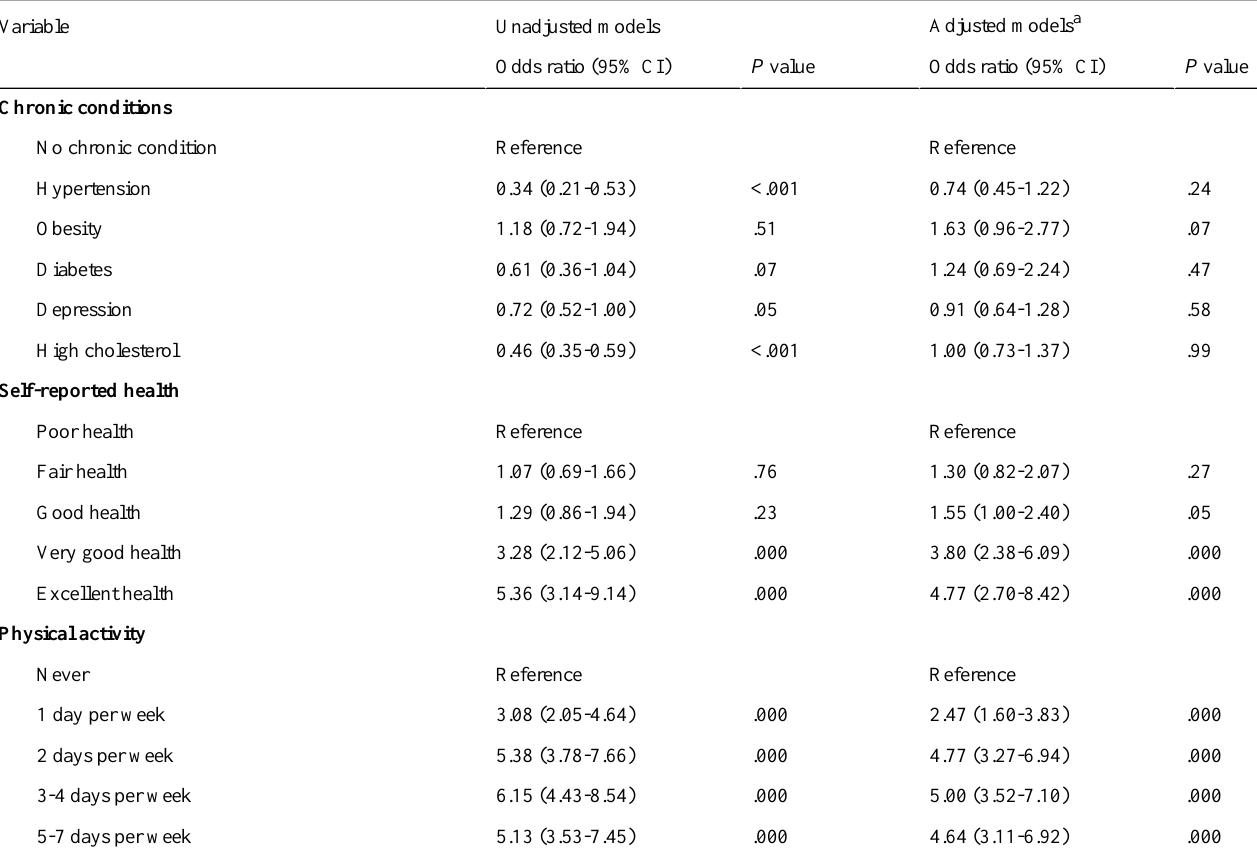
Table 3. Health app download, self-reported health, and physical activity by chronic condition (N=1604).